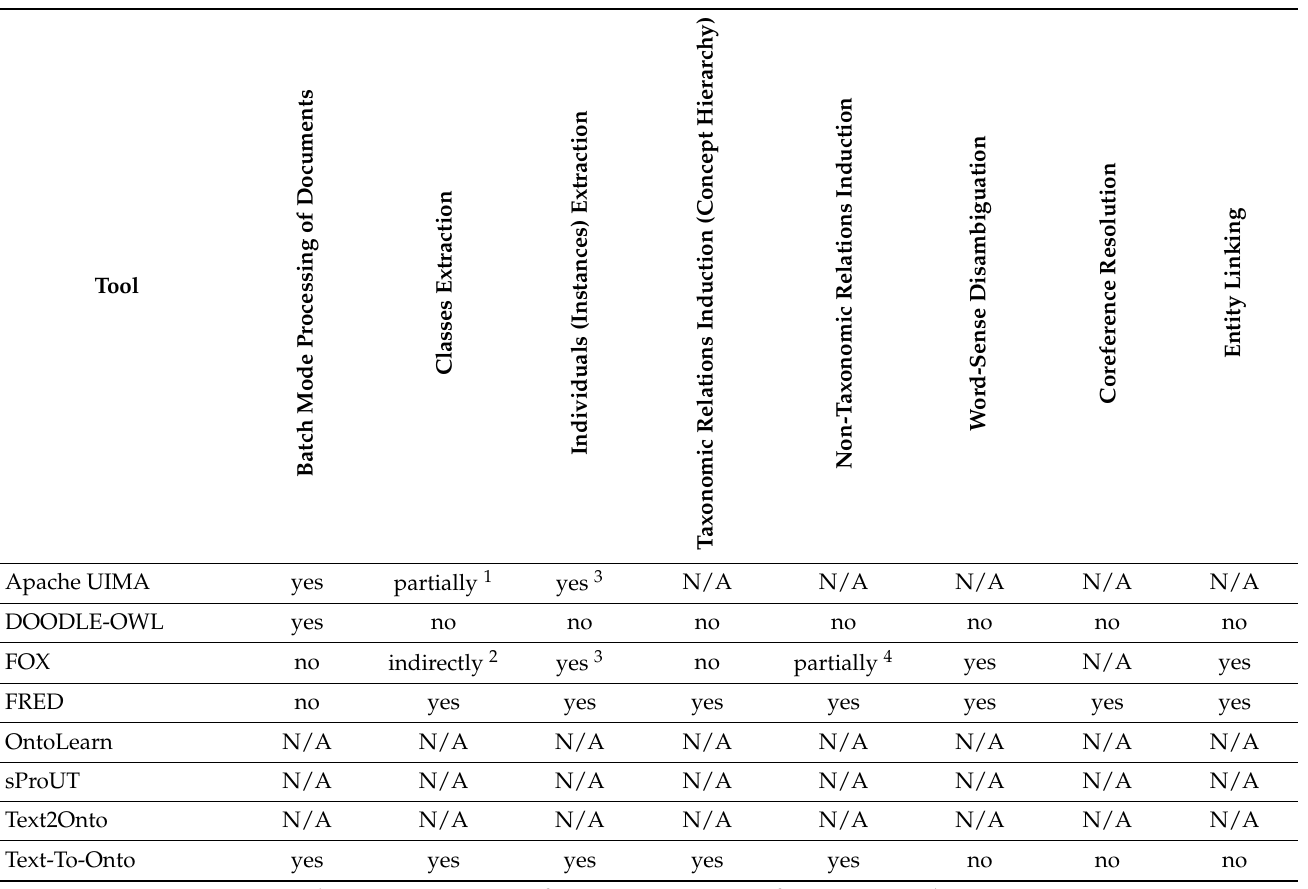
Table 7. Functionalities explored in the